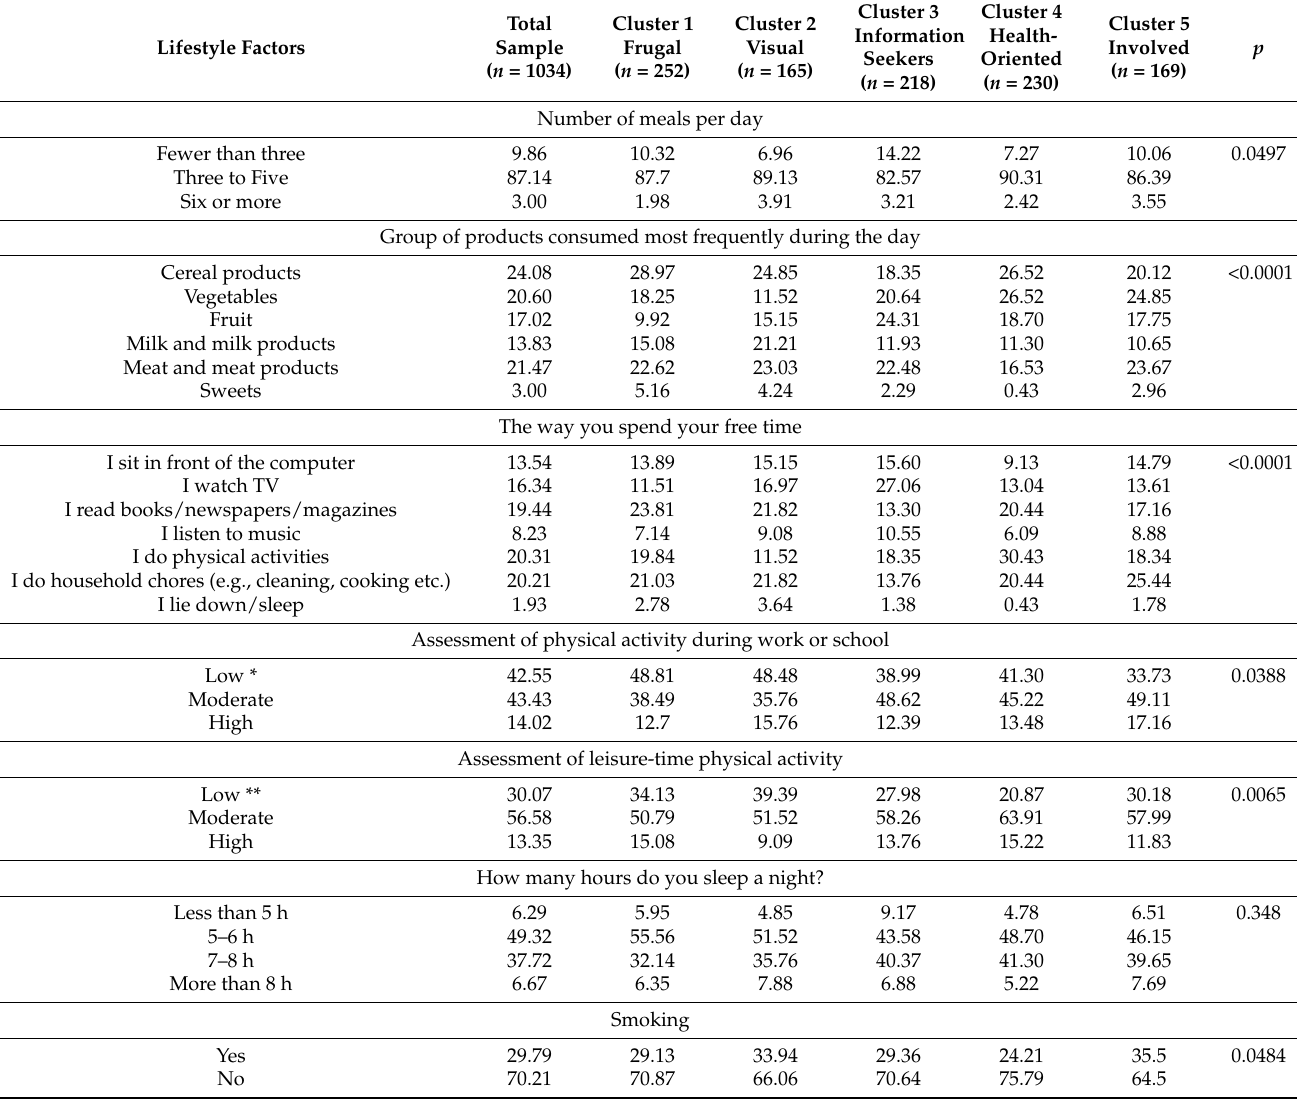
Table 7. Profile of clusters in terms of lifestyle factors (%, n = 1034,